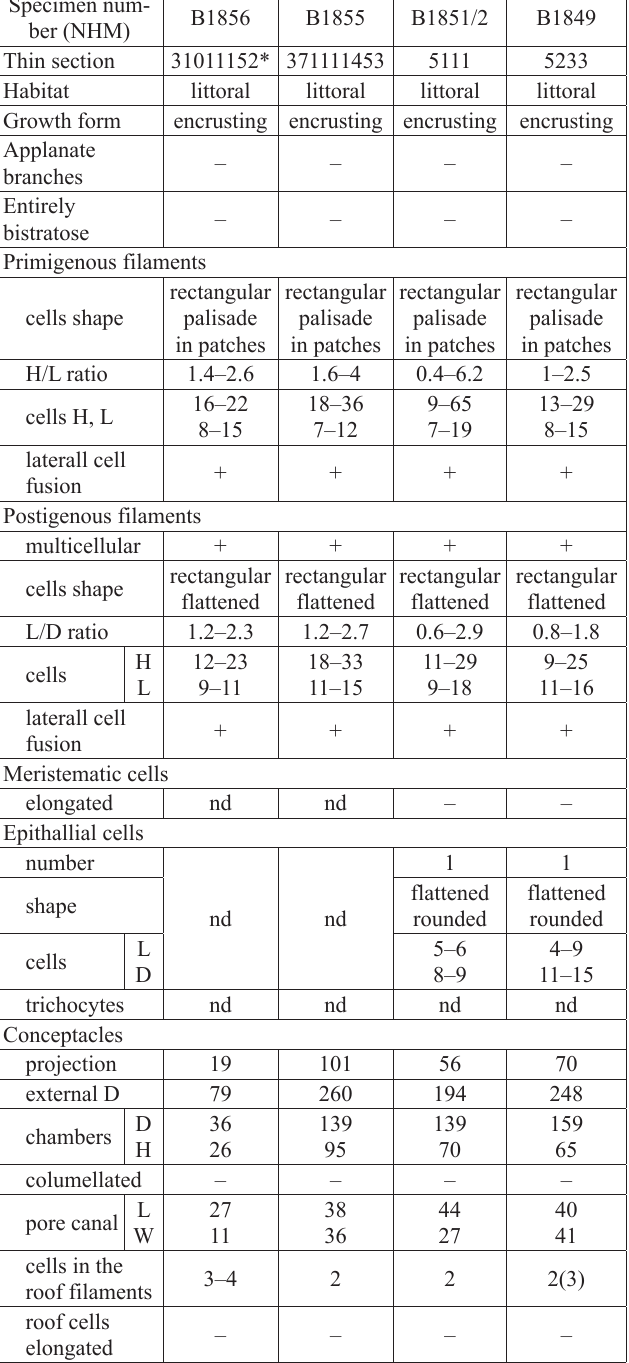
Table 8. Comparative table of selected Lithoporella sp. 1 specimens from Vienna Basin. * marks gametangial or carpogonial- carposporangial plants. Abbreviations: D, diameter; H, height; L, length; W, wide; nd, no data; “+” presence and “–” absence of character. All measurements in μ